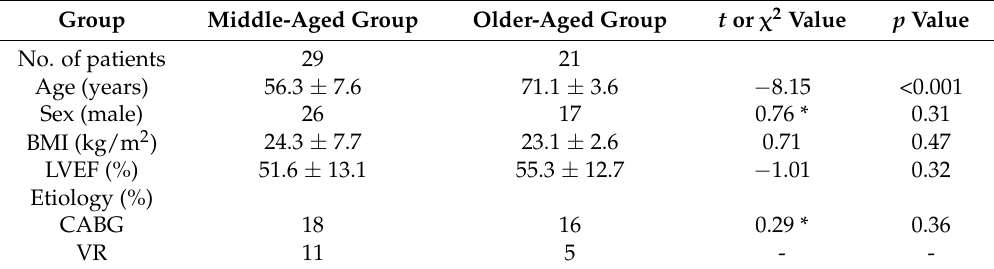
Table 1. Clinical characteristics of the patients.